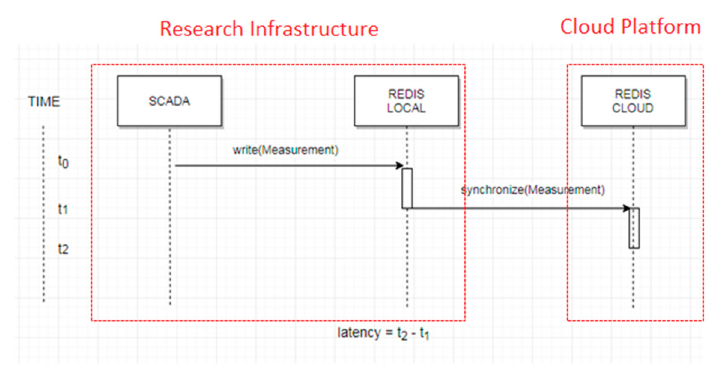
Figure 5. Conceptual model to test latency for JaNDER Level 0.